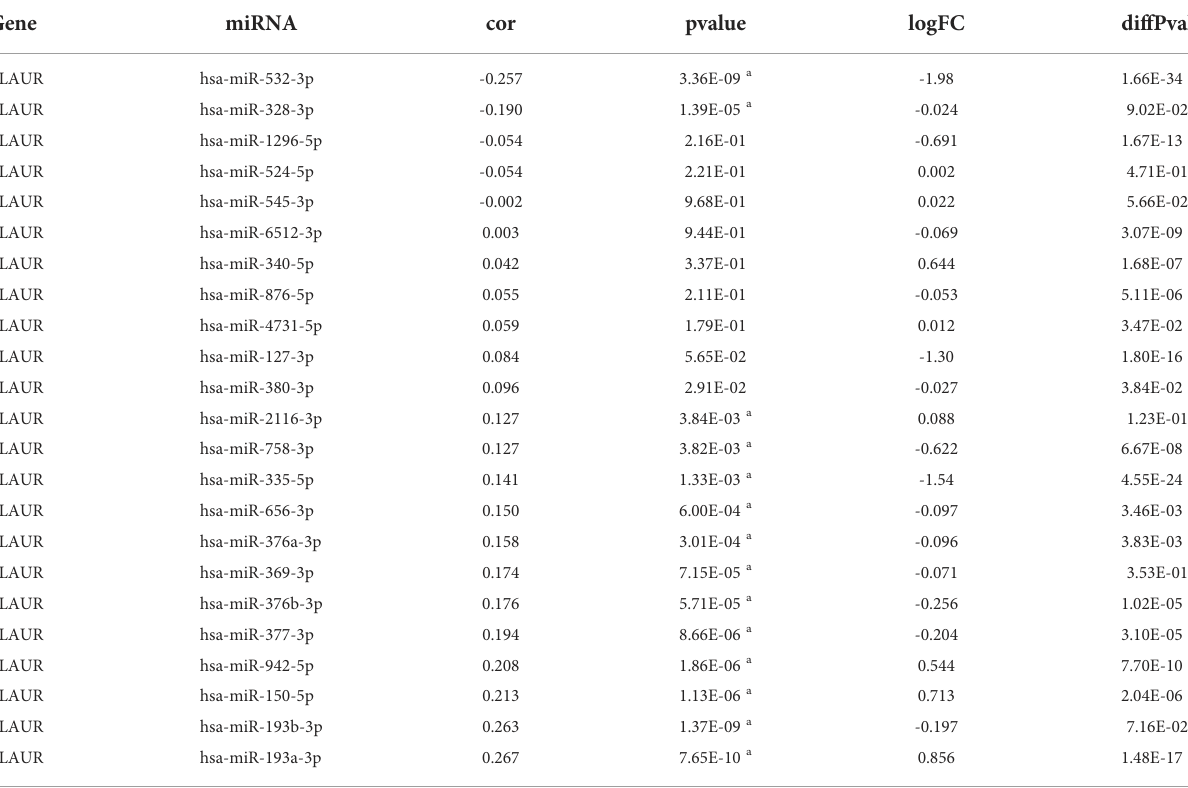
TABLE 1 The expression correlation analysis between predicted miRNAs and PLAUR and the differential expression analysis of predicted miRNAs.